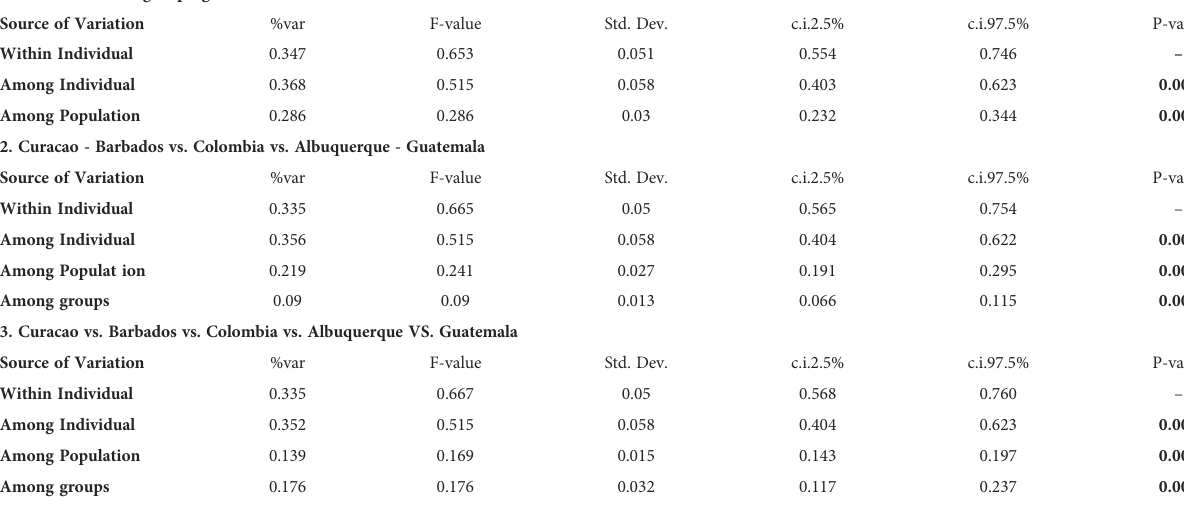
TABLE 2 Results of AMOVA. Variance for M. auretenra using two different